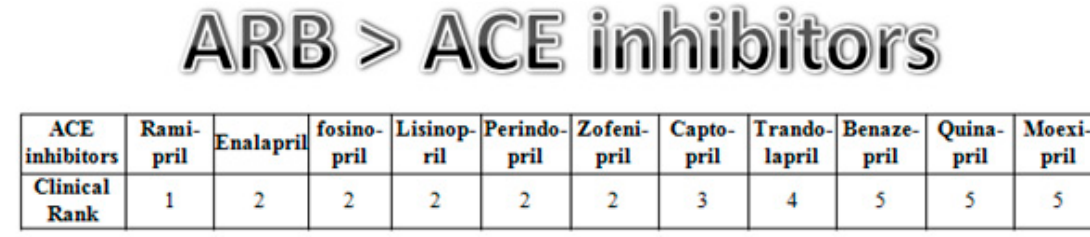
Figure A1. Summary of the Relations of Clinical